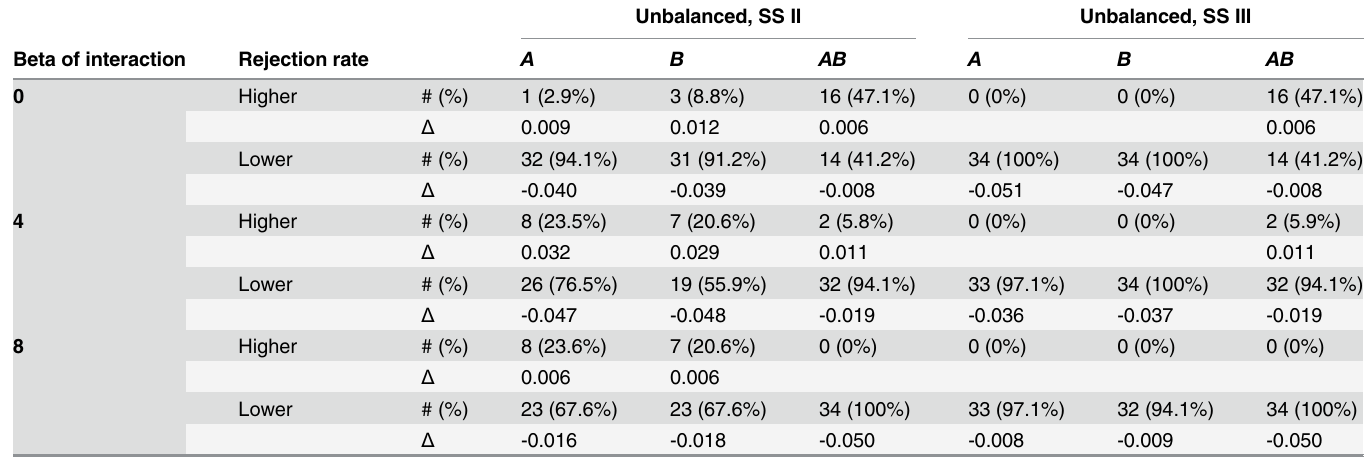
Table 8. Number of unbalanced designs (percentages of all 34 designs) with rejection rates of H0 that are higher or lower when compared to the re- jection rates of the balanced data (incongruous